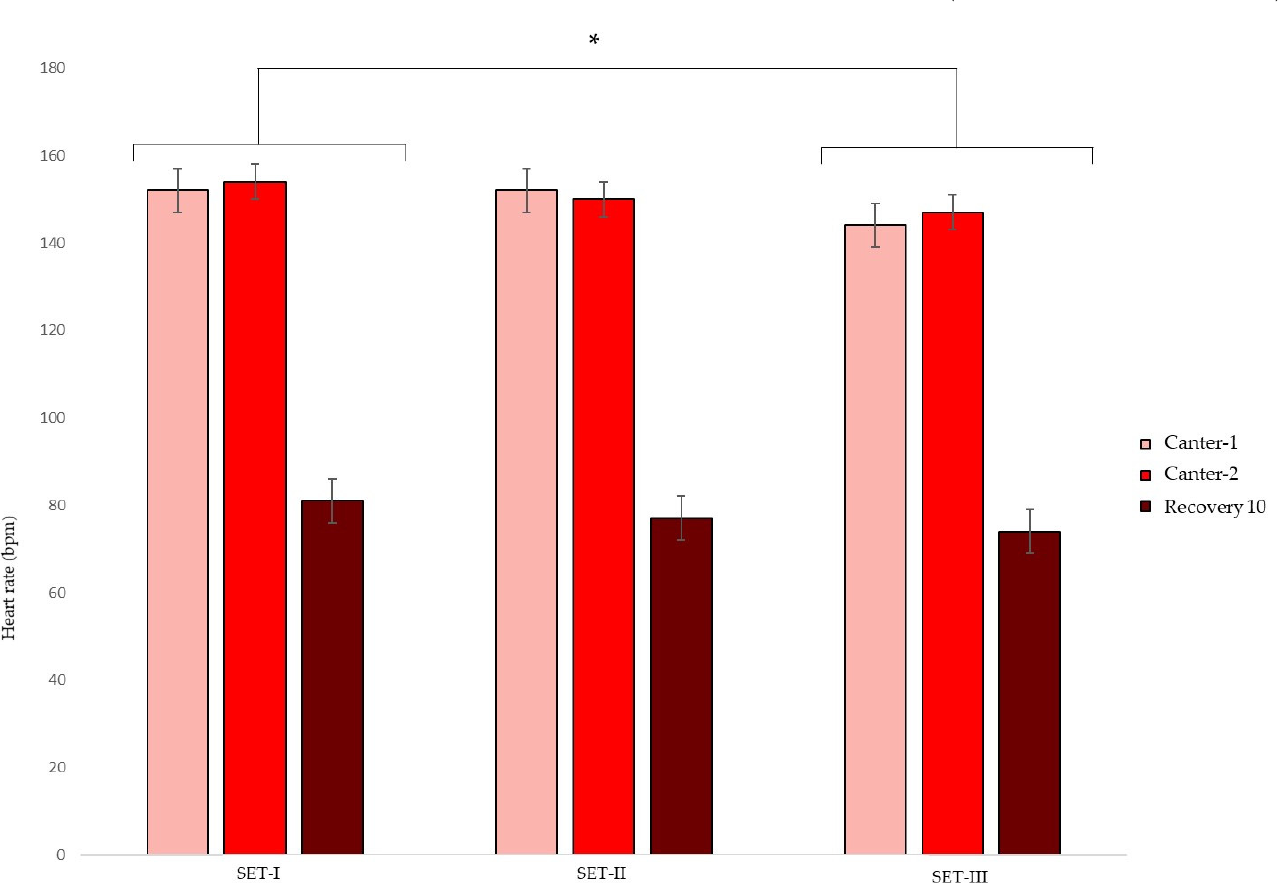
Figure 2. Mean ± s.d. heart rate (bpm) during three consecutive standardized exercise tests (SET-I, SET-II, and SET-III) in young Friesian stallions with 5 (SET-I -SET-II) and 4 (SET-II–SET-III) weeks in between. * Indicating an overall statistical difference from SET-I.